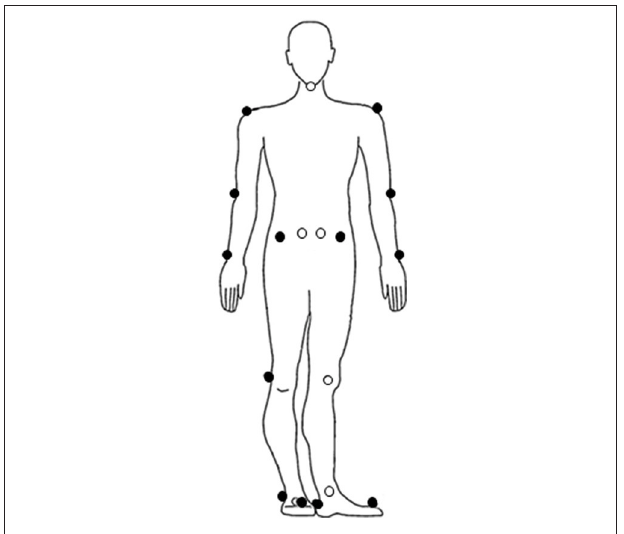
FIGURE 3 | Placement of the reflective